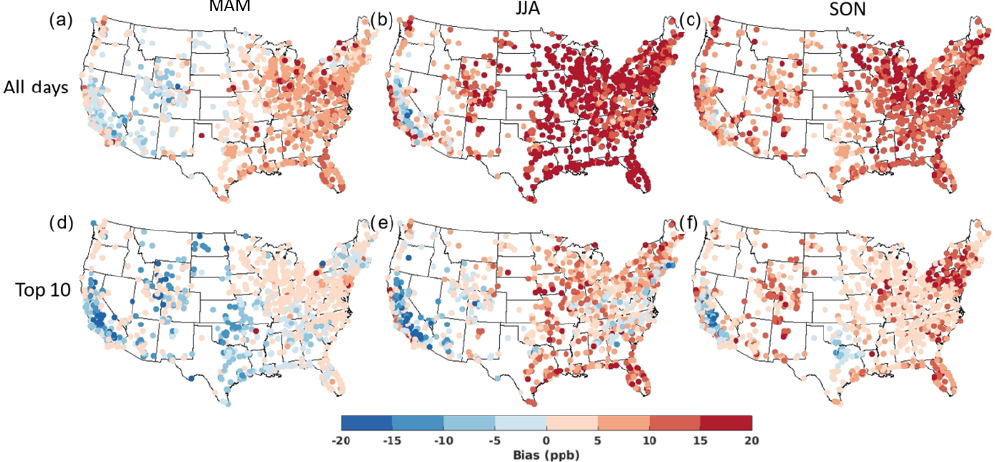
Figure 2. Average MDA8 O 3 model bias (O 3 _Base – observed) on all days in (a) MAM, (b) JJA, and (c) SON versus on